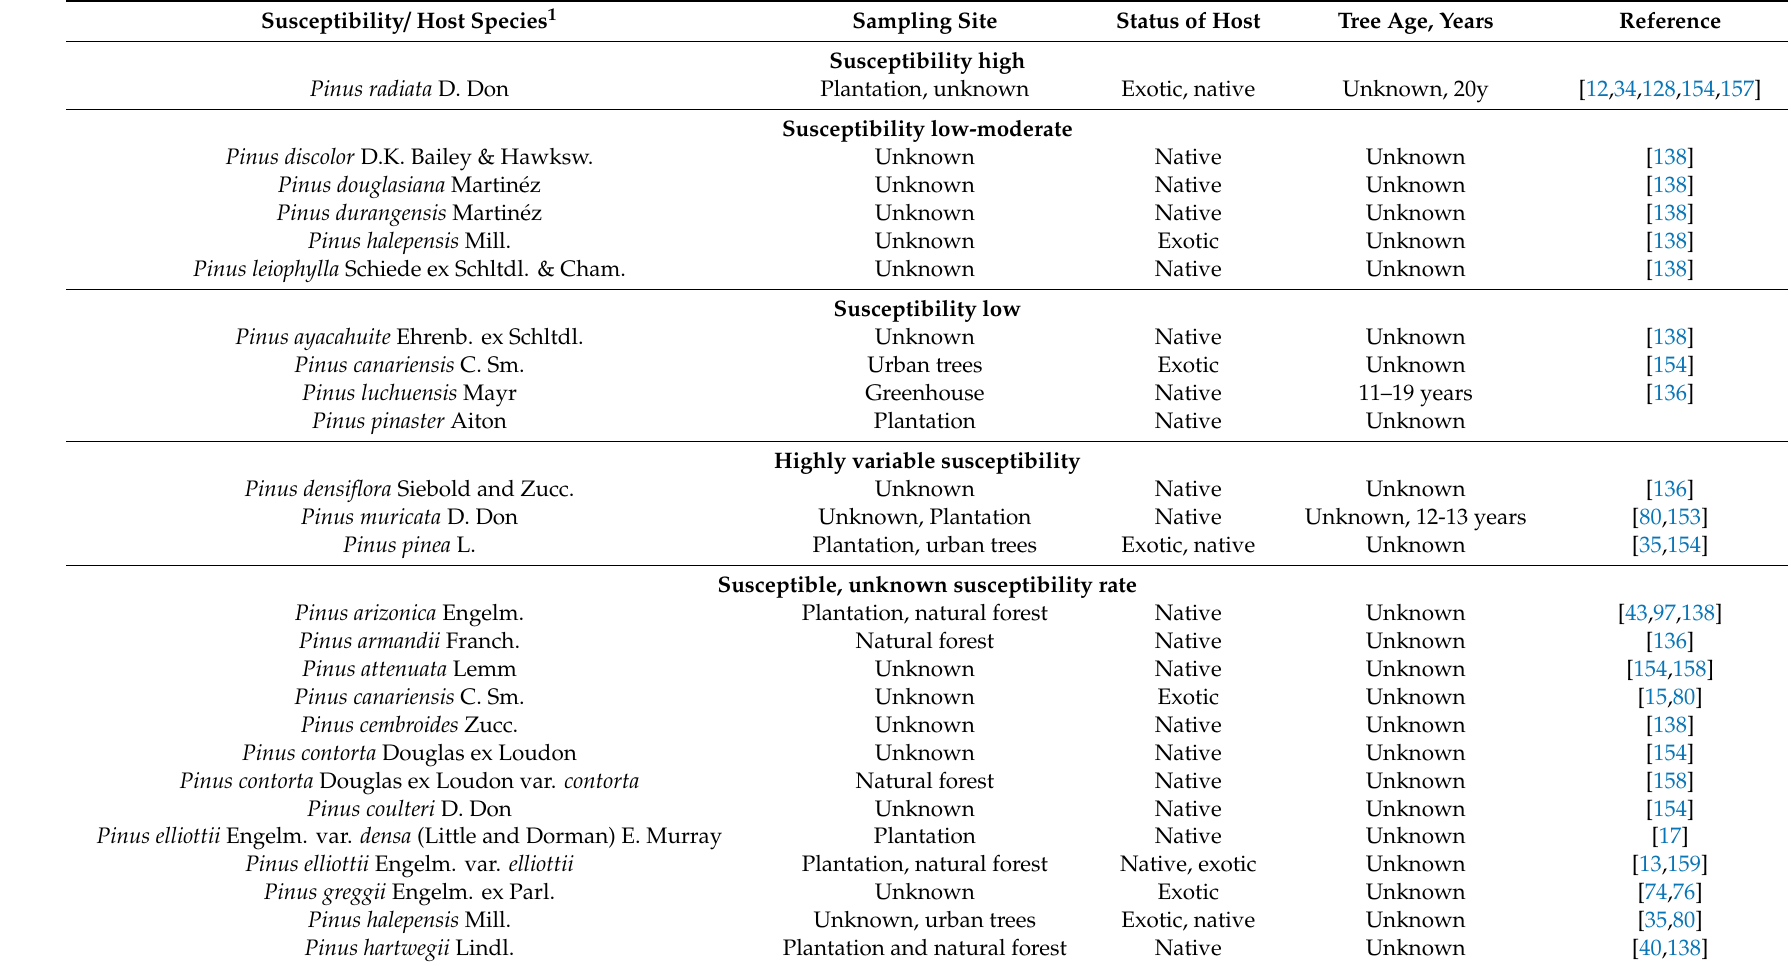
Table 4. Susceptibility list of Pinus species mature trees ( ≥ 11 years) to Fusarium